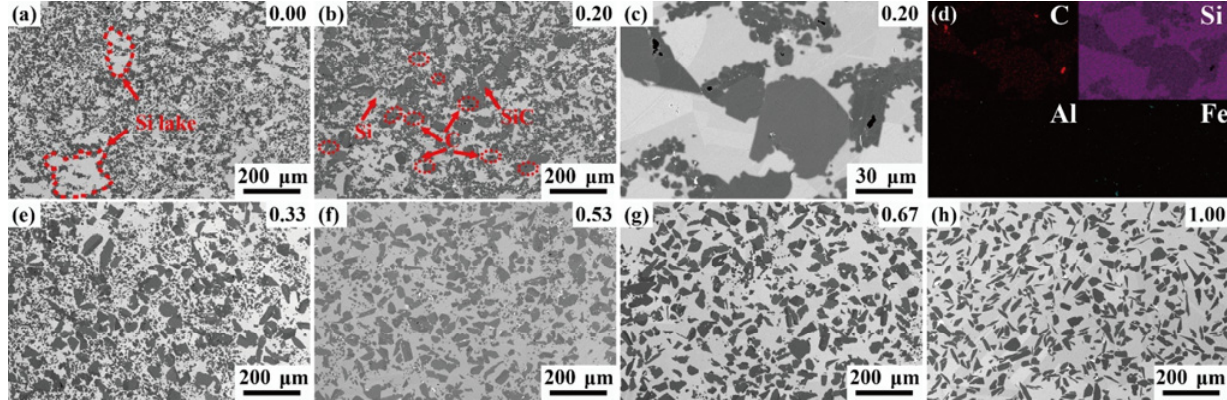
Fig. 10 Polished surface morphologies of SiC composites (back-scattered electron SEM): (a) SiC:IM = 0; (b) SiC:IM = 0.20; (e) SiC:IM = 0.33; (f) SiC:IM = 0.53; (g) SiC:IM = 0.67; and (h) SiC:IM = 1. (c) High-magnification SEM micrograph of SiC:IM = 0.20. (d) EDS mappings of SiC:IM =